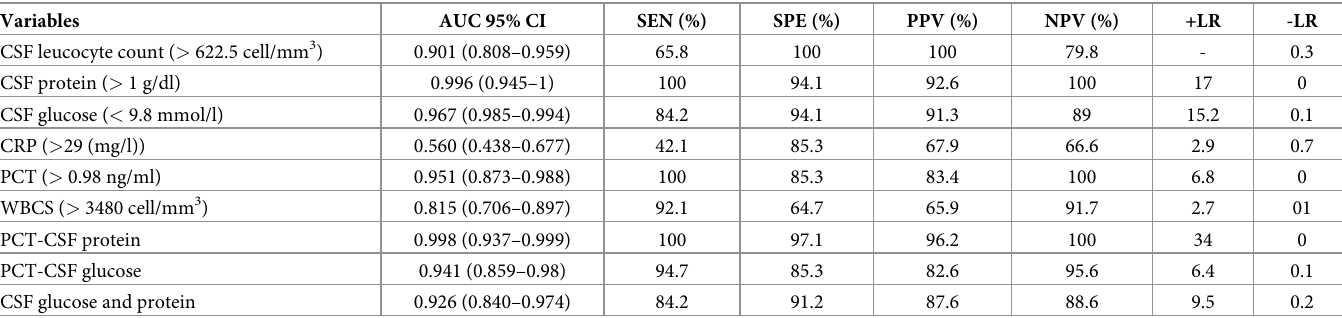
AUC: area under the curve; SEN: sensitivity; SPE: specificity; PPV: positive predictive value; NPV: negative predictive value; +LR: positive likelihood ratio; -LR: negative likelihood ratio.